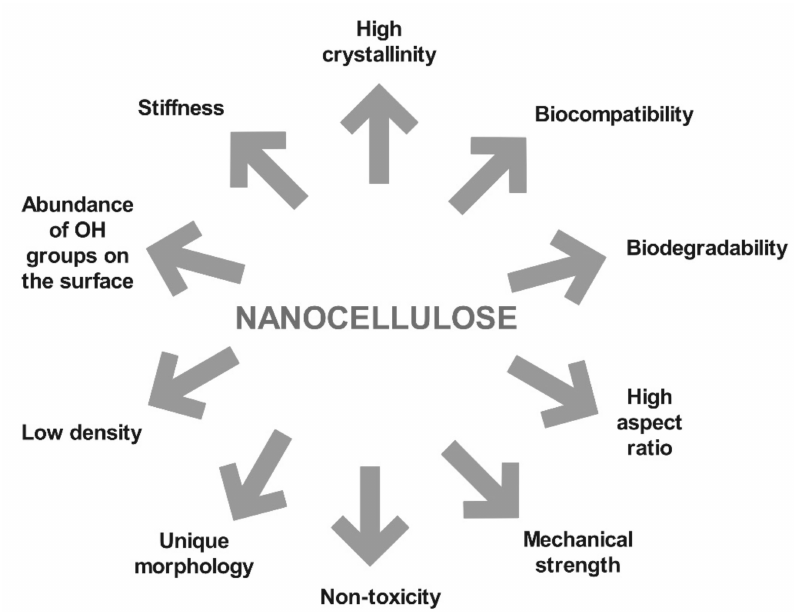
Figure 3. Unique properties allow the use of nanocellulose in many Biomedical applications